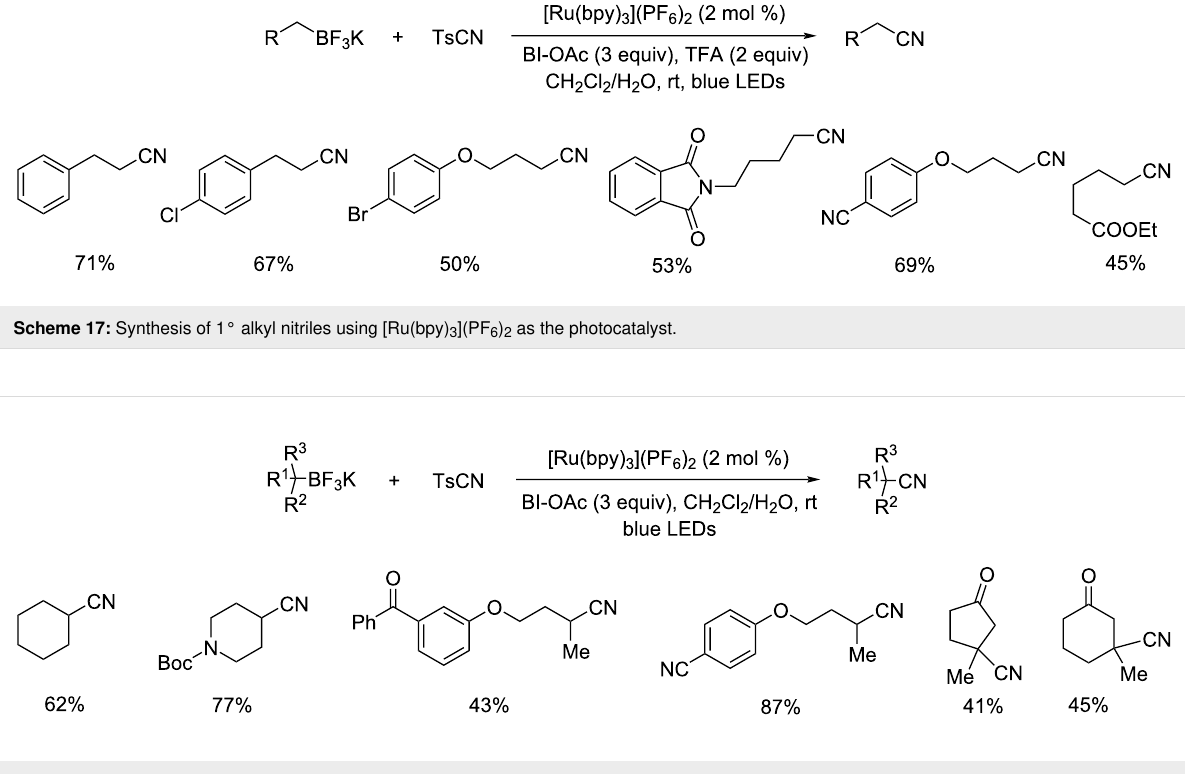
Scheme 18: Synthesis of 2° and 3° alkyl nitriles using [Ru(bpy) 3 ](PF 6 ) 2 as the